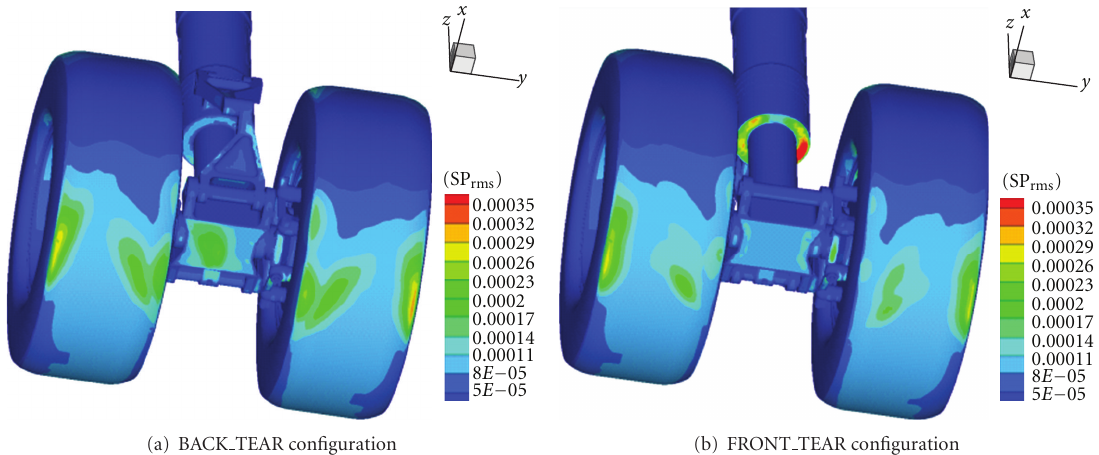
Figure 13: Comparison of surface sound pressure fluctuation below the wheel.